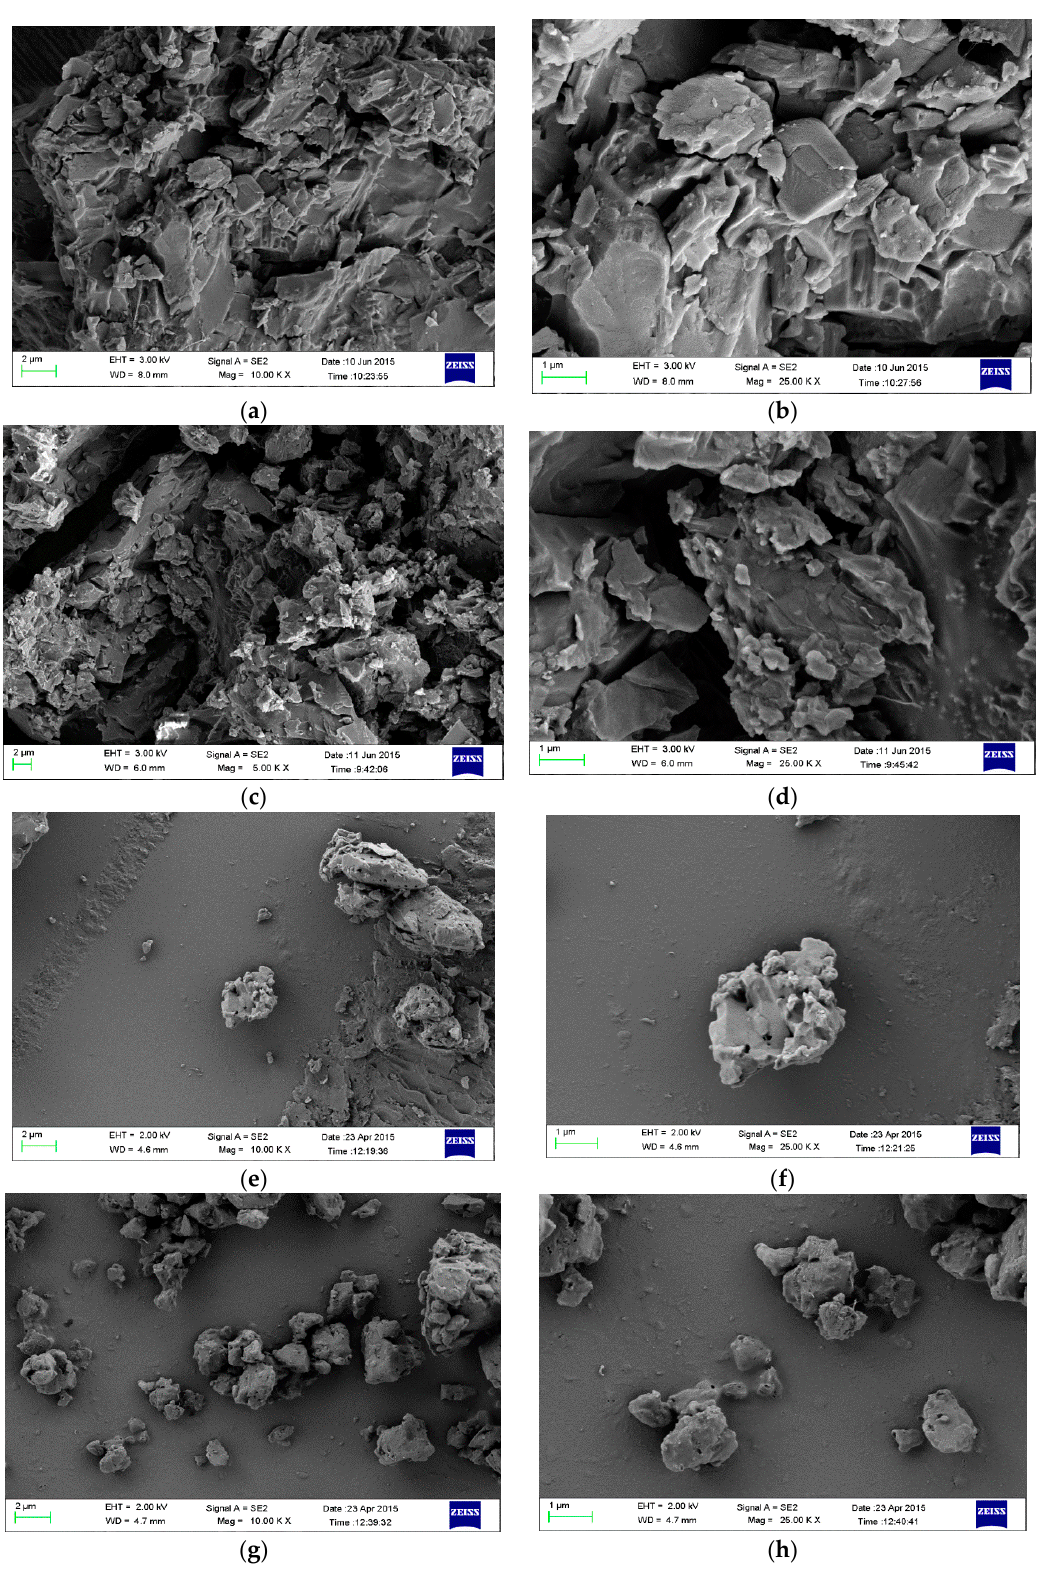
Figure 8. CUR-ART in SGF/SIF at 2 µm and 1 µm resolution. ( a , b ) are slurry material in SGF at 1 h; ( c , d ) are slurry material in SGF at 2 h; ( e , f ) are slurry material in SGF at 24 h; ( g , h ) are slurry material in SIF at 24 h. The agglomerates of larger particles up to 2 h time point have separated/dissociated to give smaller particles by 24 h.